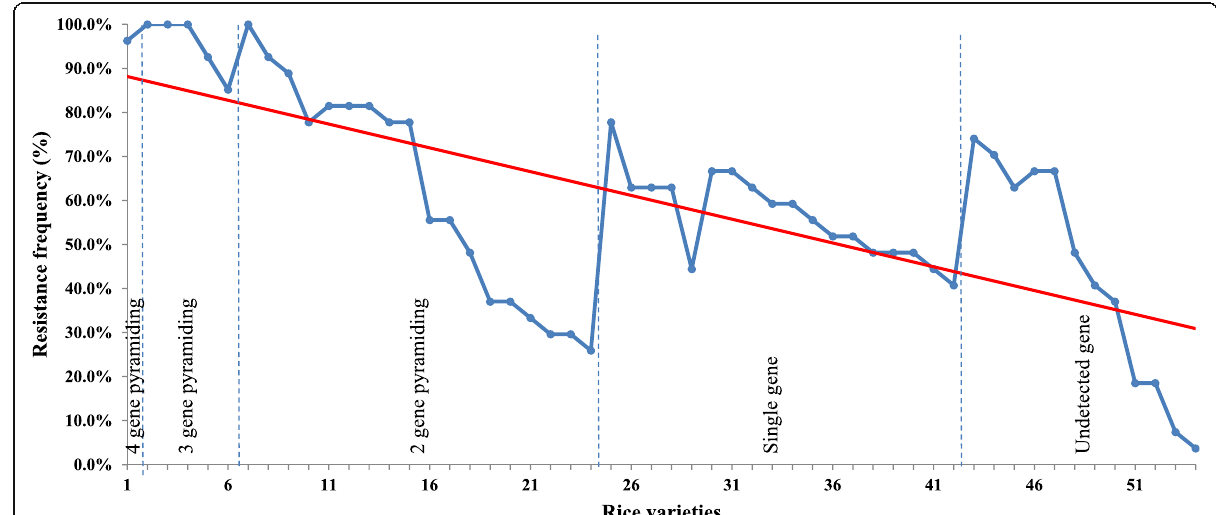
Fig. 2 Resistance frequency of 54 rice varieties. Rice varieties are listed in the order of number of pyramided R genes as in Additional file 6: Table S4. The number of pyramided R genes is indicated by lines. The regression curve is drawn along the resistance